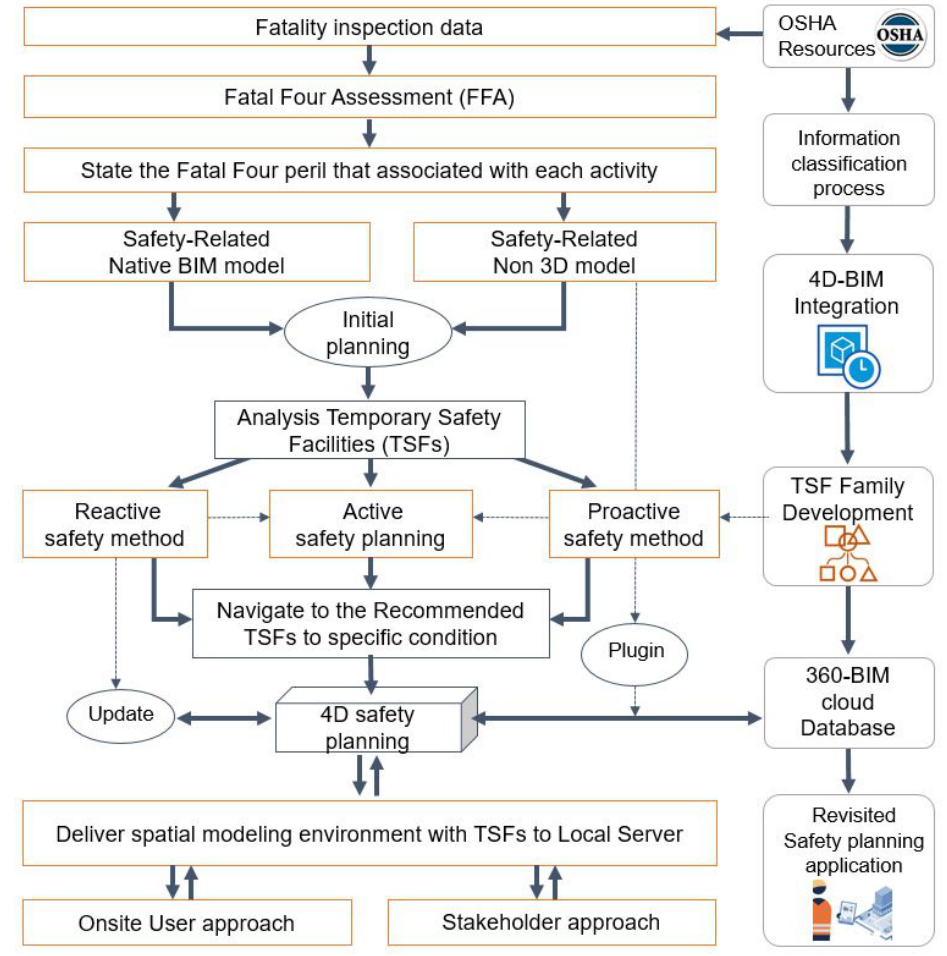
Figure 6. Information flowchart of the process of generating